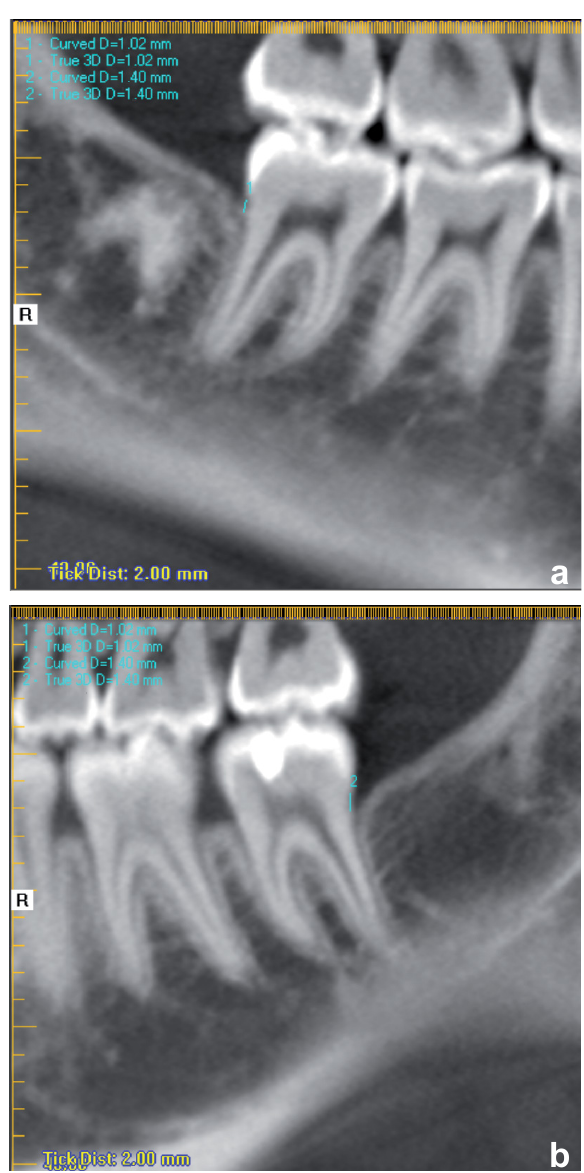
Figure 1- Sockets filled with Gen-Tech ® in study conducted by Munhoz, et al. 15 (2006)